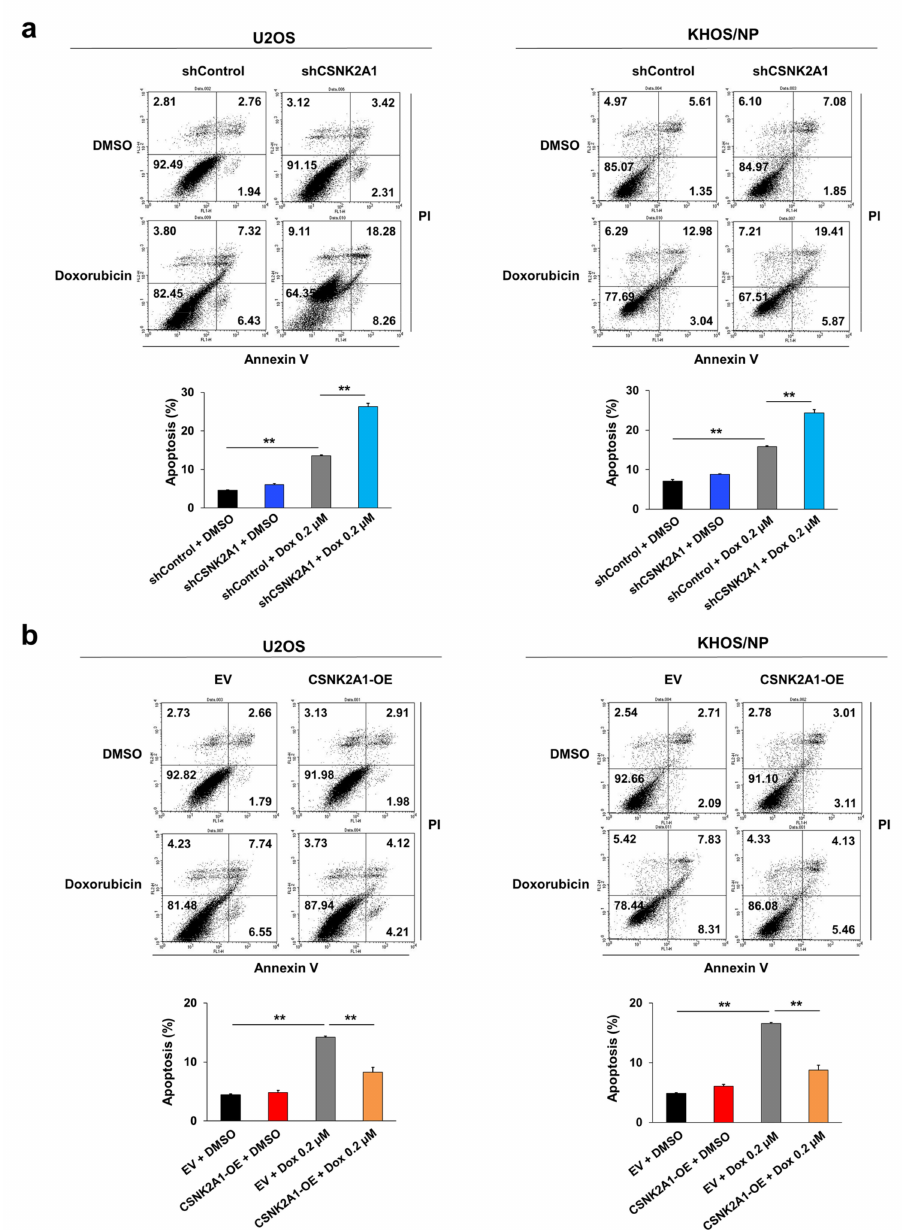
Figure 5. CSNK2A1 involvement in the apoptotic effects of doxorubicin in osteosarcoma cells with flow cytometry analysis. ( a ) U2OS and KHOS/NP osteosarcoma cells were transfected with control shRNA or shRNA for CSNK2A1 and treated with 0.2 µ M doxorubicin for 24 h. ( b ) U2OS and KHOS/NP osteosarcoma cells were transfected with empty vector or wild-type CSNK2A1 and treated with 0.2 µ M doxorubicin for 24 h. The apoptosis of cells was evaluated via flow-cytometry analysis with staining with propidium iodide and for annexin V. **; p < 0.001. 3.4. CSNK2A1-Mediated Resistance to Doxorubicin Is Associated with SIRT6 Phosphorylation-Mediated Activation of the DNA Damage Repair Pathway When U2OS and KHOS/NP osteosarcoma cells were treated with doxorubicin, the expression of pSIRT6, pATM, pChk2, and γ H2AX were increased (Figure 6). In addi- tion, under treatment with doxorubicin in U2OS and KHOS/NP cells, the knock-down of CSNK2A1 decreased the expression of pSIRT6, pATM, and pChk2, and the overex- pression of CSNK2A1 increased the expression of pSIRT6, pATM, and pChk2 (Figure 6). The expression of γ H2AX increased with the knock-down of CSNK2A1 and